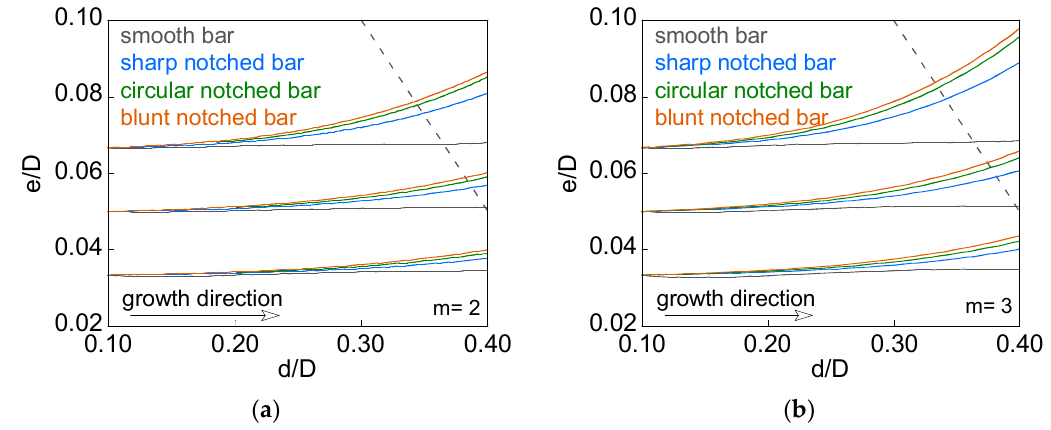
Figure 14. Fatigue propagation for three cracks with initial geometries ( d / D ) 0 = 3/30 and ( e / D ) 0 = {1/30, 1.5/30, and 2/30}: ( a ) m = 2; ( b ) m = 3.